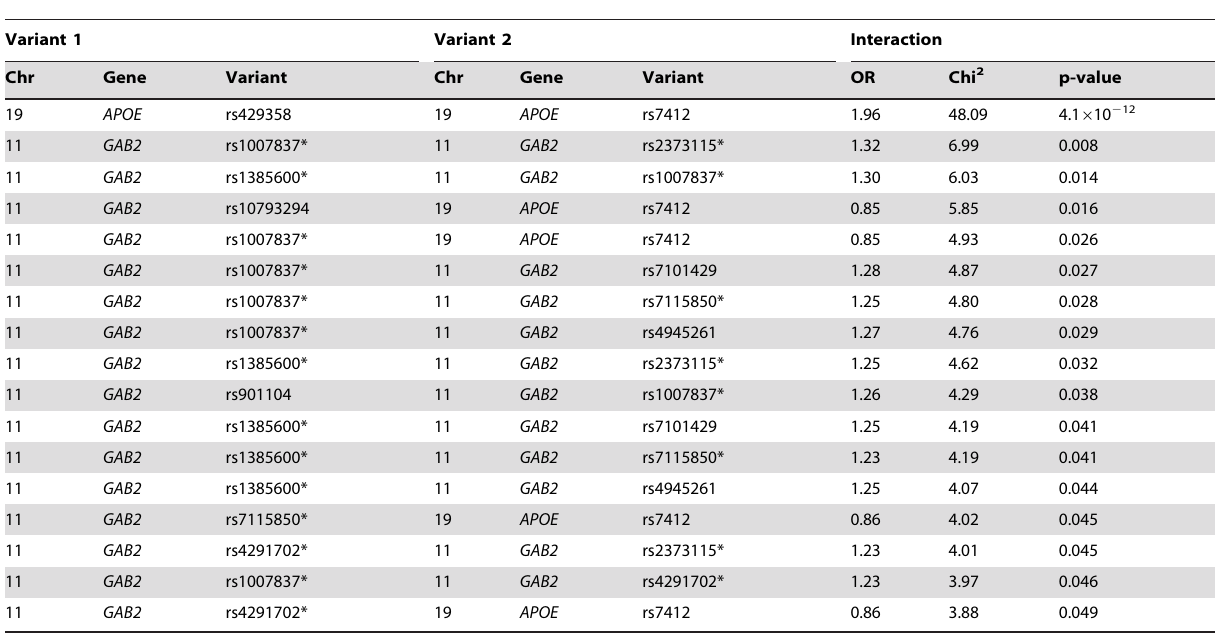
Table 5. Pair-wise epistatic interaction tests between variants in GAB2 and APOE .